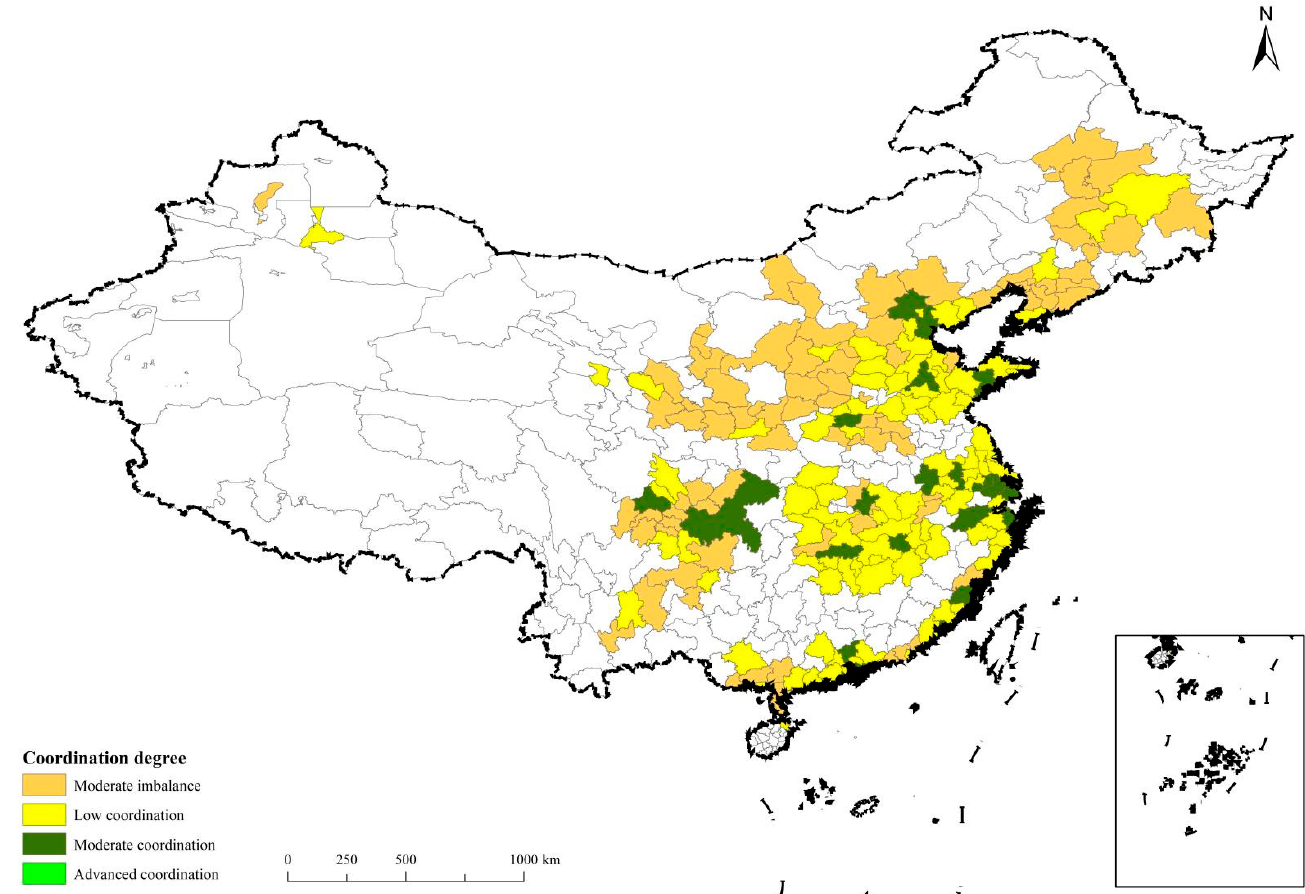
Figure 5. Coupling result of economic-social-ecological resilience in Chinese urban agglomera- tions.